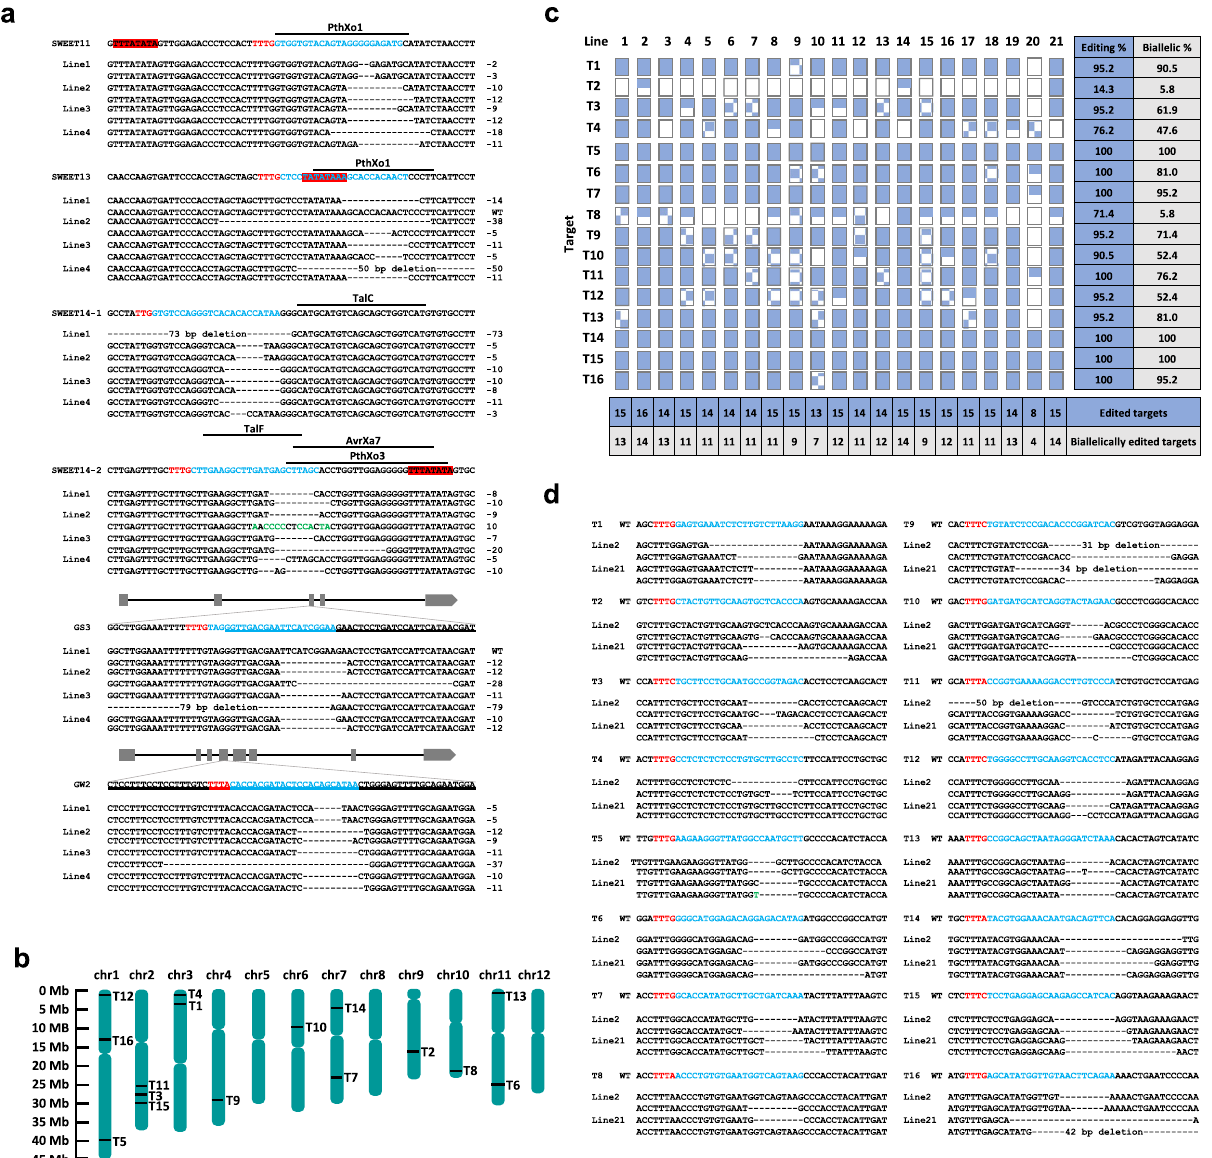
Fig. 4 Highly ef fi cient large-scale biallelic genome editing in rice. a Simultaneous editing of six sites by Mb2Cas12a for multiplexed engineering of quantitative traits in rice. Genotypes of four independent T 0 lines are shown, indicating all the target sites are nearly edited biallelically. The PAM sites are highlighted in red and the target sequences are highlighted in blue. The TATA boxes are painted in red. The TAL effector binding sites in the promoters of the SWEET genes are indicated by solid black lines above the sequences. Exons of GS3 and GW2 are underlined. b Schematics of simultaneous editing by LbCas12a at 16 different target sites (T1 – T16) across nine rice chromosomes (chr). c Genotypes of 21 tested T 0 lines at 16 target sites, with wild type denoted as empty rectangles, monoallelic mutants denoted as half- fi lled rectangles, biallelic mutants denoted as fully fi lled rectangles, and chimeras denoted as doted rectangles. d Genotypes of T 0 Line 2 and Line 21 at 16 target sites, where 14 sites were biallelically edited in both